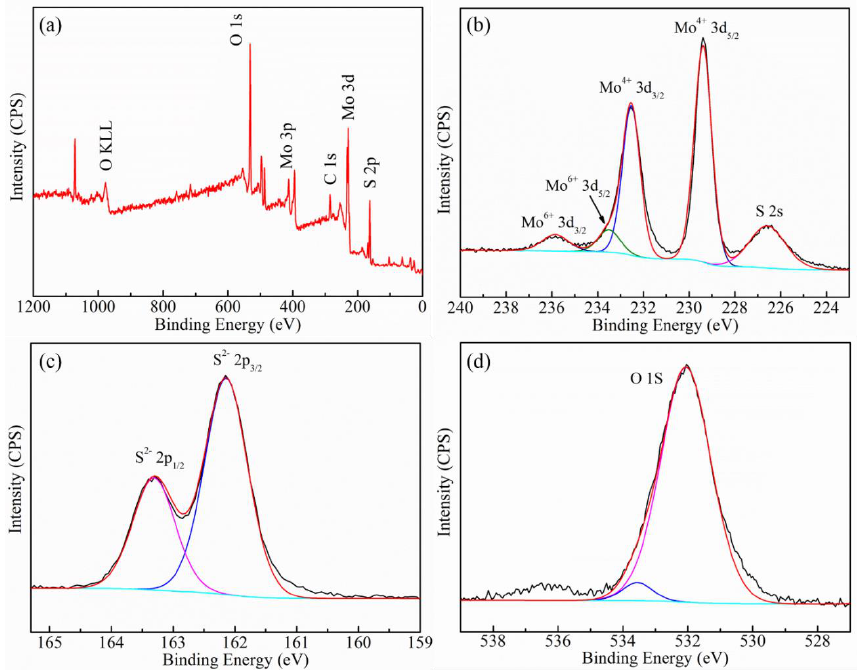
Figure 4. XPS survey spectra of MoS 2 ( a ) and high-resolution scans of Mo3d ( b ), S2p ( c ), O1s ( d ).